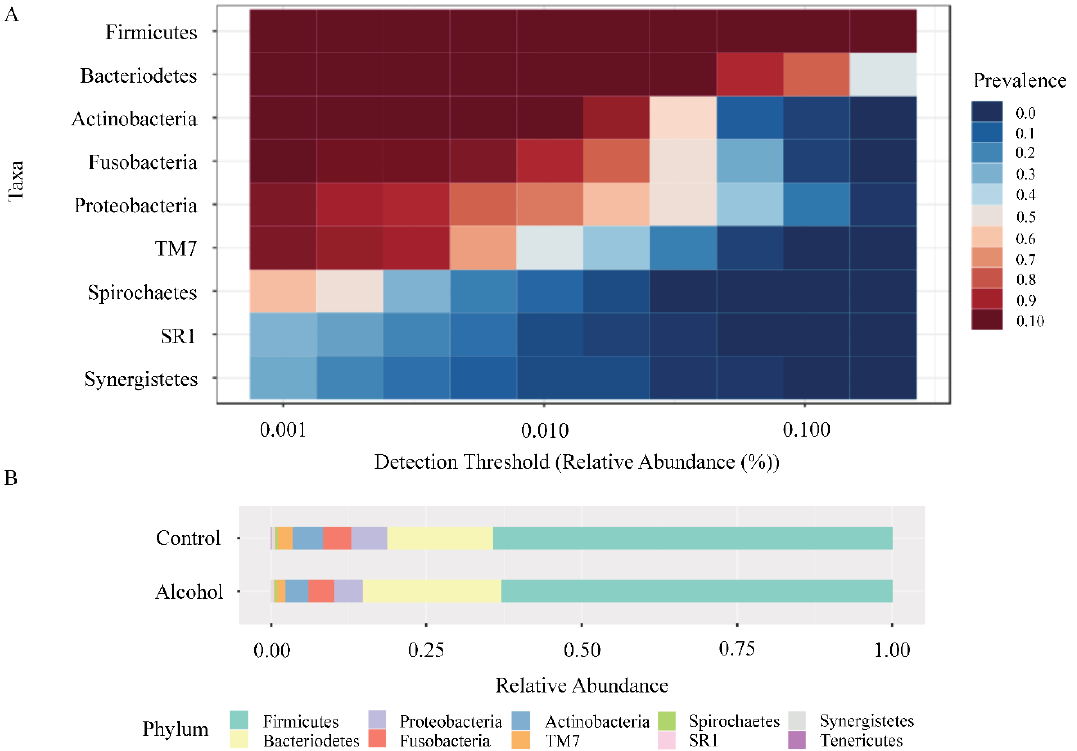
Figure 2. Microbial communities identified at the phylum level. ( A ) Heatmap of the core microbiome analysis to identify core taxa at phylum level. A total of 49 samples are included in the visual representation of the taxonomic relative abundance at phylum level. The y -axis represents the prevalence level of core features across the detection threshold (relative abundance) range on x -axis. The variation of prevalence of each phylum is indicated by a gradient of color from blue (decreased) to red (increased). ( B ) Taxonomic composition of alcohol group and control group at the phylum level. Visual exploration to evaluate taxonomic composition of community through direct quantitative comparison of relative abundances was performed by using stacked bar chart.